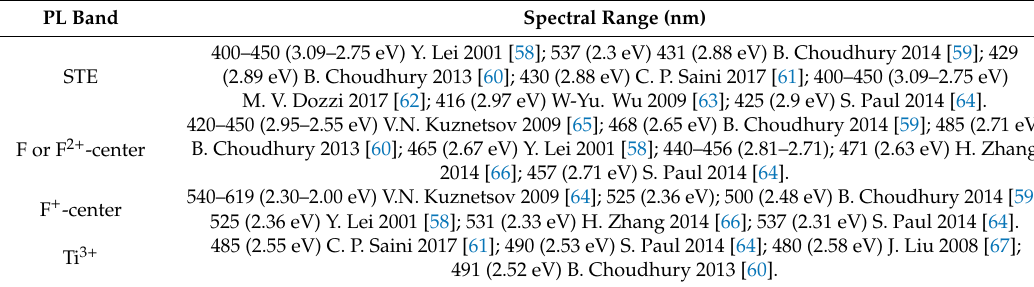
Figure 7. Photoluminescence spectra of titania powders: λ ex = 300 nm ( a ) and λ ex = 405 nm ( b ). Table 4. Interpretation of the PL spectra bands.